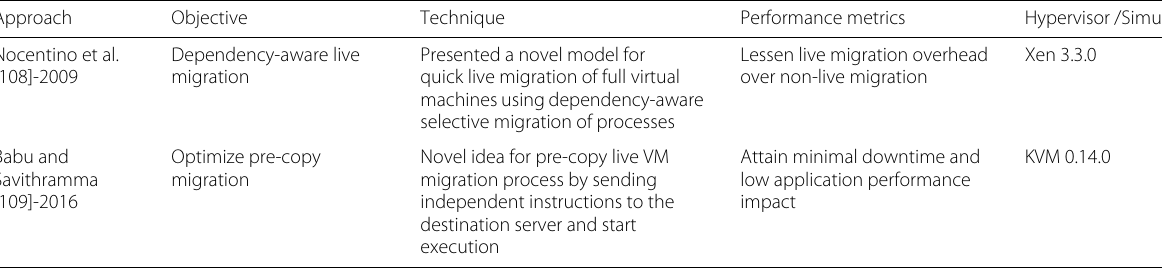
Table 10 Comparison of Dependency aware VM migration approaches